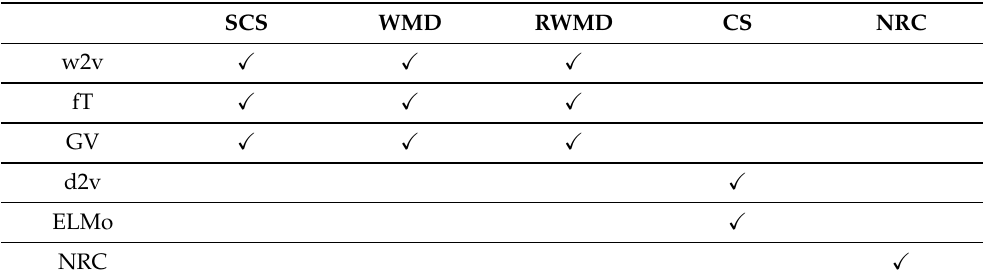
Table 2. The different combinations of measures (columns) and embedding techniques (rows) used in the experiments. Being imprecise, NRC would be the embedding and the similarity measure at the same